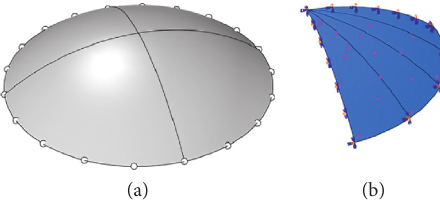
Figure 2: Optimization parameters of spherical shell. (a) Whole structure. (b) 1/4